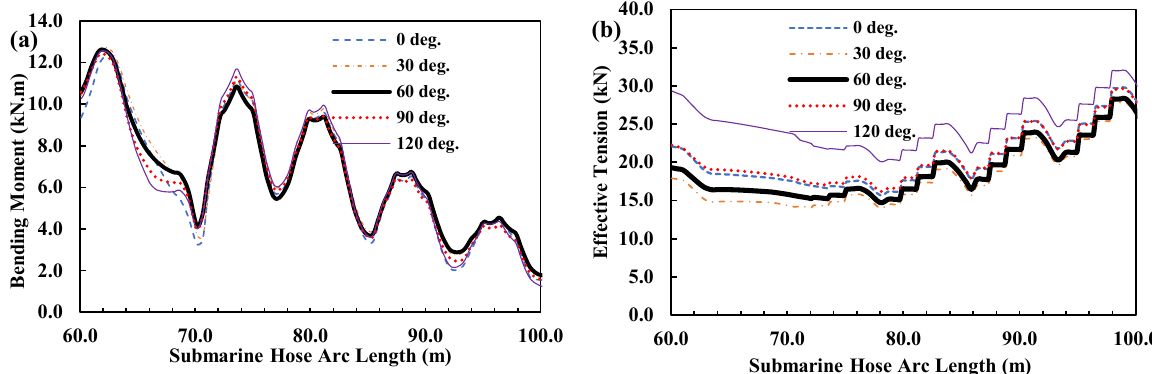
Figure 28. Influence of surface wave direction for the submarine hoses . ( a ) Bending Moment for hose arc lengths 60 – 100 m. ( b ) Effective Tension for hose arc lengths 60 – 100 m.